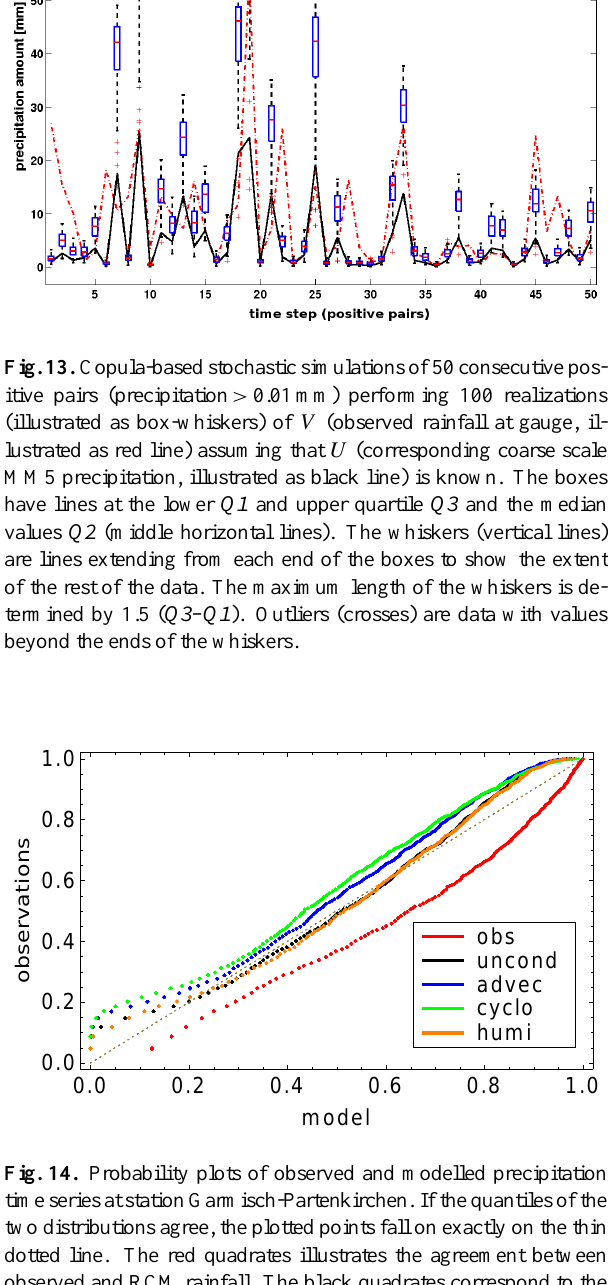
Fig. 14. Probability plots of observed and modelled precipitation time series at station Garmisch-Partenkirchen. If the quantiles of the two distributions agree, the plotted points fall on exactly on the thin dotted line. The red quadrates illustrates the agreement between observed and RCM rainfall. The black quadrates correspond to the Copula-based stochastic simulations without additional large-scale information. The Copula-based simulations including advection, cyclonality, and humidity of the troposphere are illustrated as blue, green, and orange quadrates respectively.